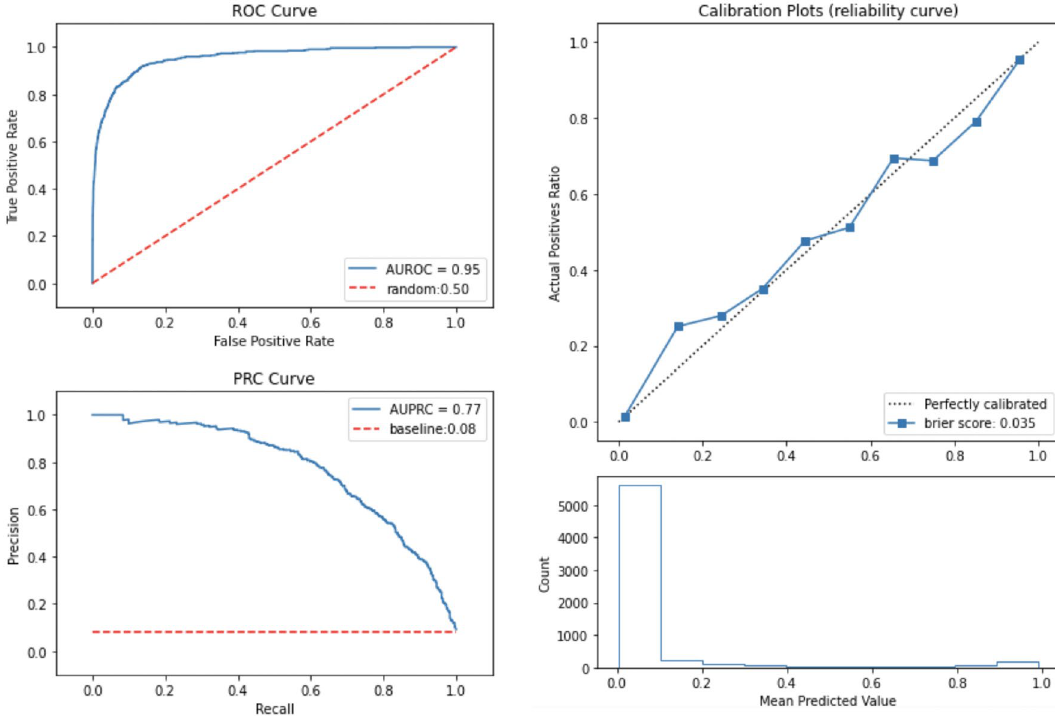
Figure 1. Model discrimination and calibration performance. AUROC area under the receiver-operating characteristic, PRC precision recall curve, ROC receiver-operating characteristic.